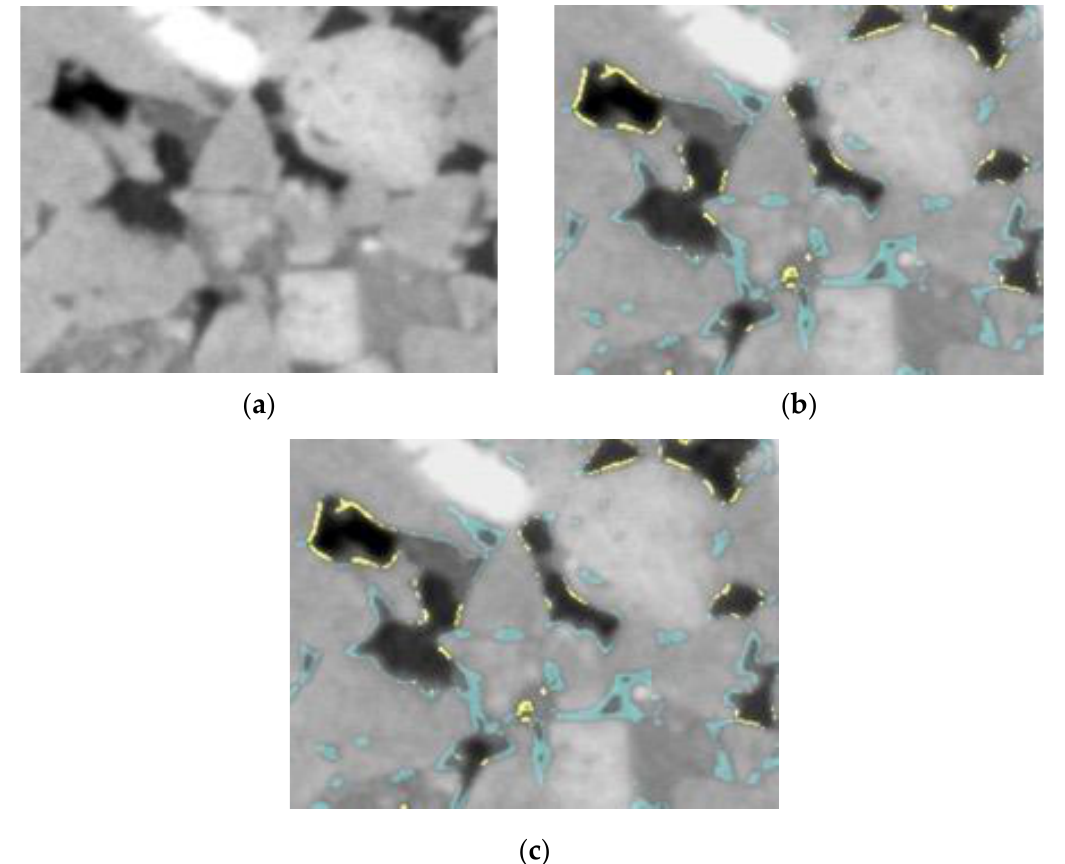
Figure 4. Impact and comparison at the local scale of the mean and median filtering with Otsu’s thresholding compared to Ilastik: ( a ) the raw reconstructed image with the impact of ( b ) mean filtering and ( c ) median filtering (right). Local zooms with the voxels corresponding to voxels considered to represent porosity with Ilastik only (relative to the cited filter + Otsu’s thresholding) in cyan; and with voxels corresponding to voxels considered to represent porosity with the cited filter associated with Otsu’s thresholding only (relative to Ilastik) in yellow.